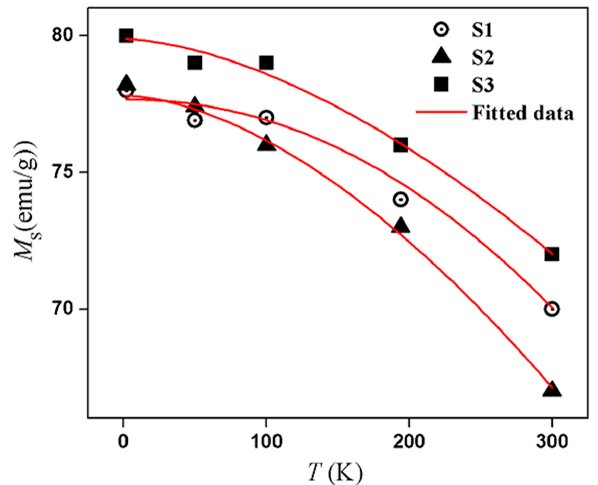
Figure 6. Temperature ‐ dependent saturation magnetization ( M S ) for samples S1 (open circle), for S2 (solid triangle), and S3 (solid square), respectively, under zero field ‐ cooling conditions.